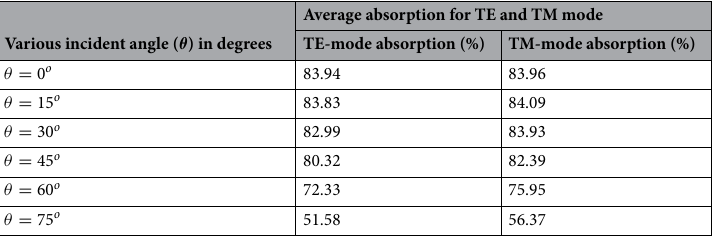
Average absorption for TE and TM mode